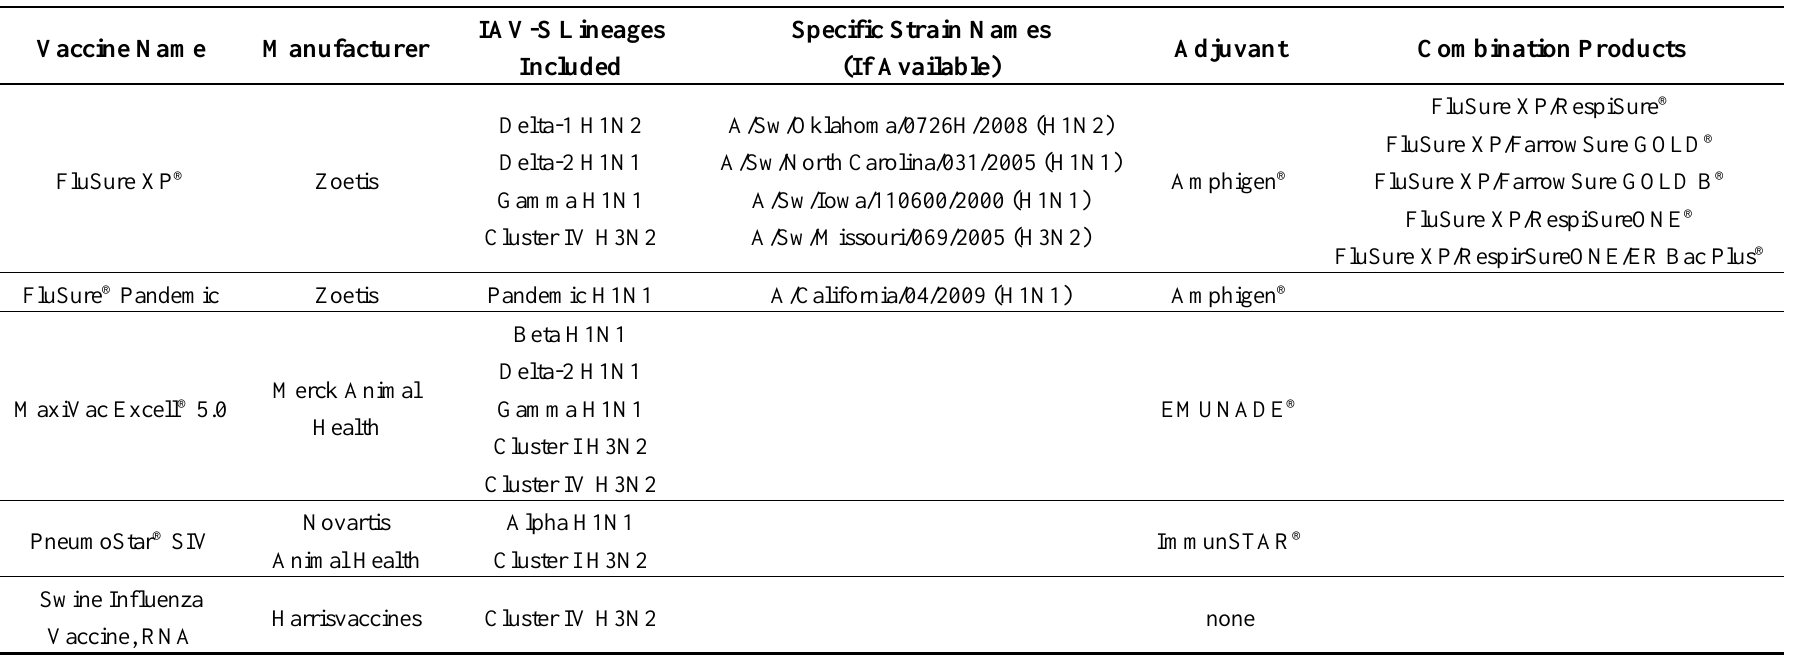
Table 3. Licensed influenza vaccines for swine in the United